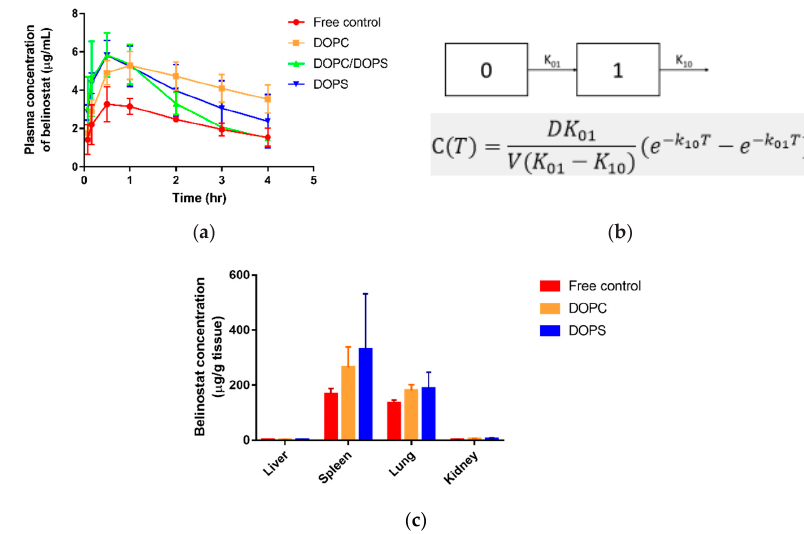
Figure 5. The cytotoxicity and cellular uptake study of belinostat-loaded liposomal formulations. ( a ) Dose response of belinostat free drug compared to belinostat-loaded liposomal formulations on HuT-78 cutaneous T-cell lymphoma cell line at the concentration of 0.5 − 10 µ M after 72 h. ( b ) The qualitative analysis of flow cytometry measurement of HuT-78 treated with belinostat-loaded liposomal formulations at 10 µ M for 4 h. Note: Rhodamine was used as a dye and was entrapped in di ff erent liposome formulations. Data are presented as mean ± standard deviation ( n = 6). There were no significant di ff erences.